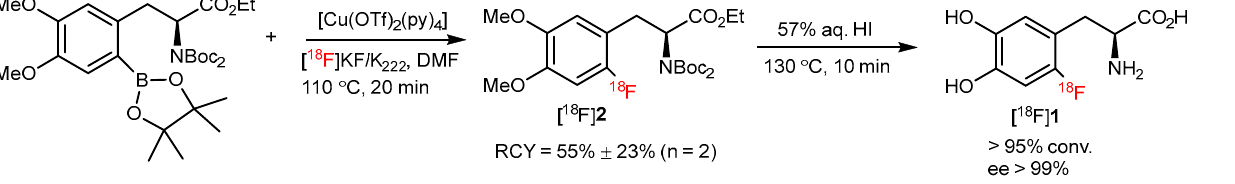
Figure 2. Radiosynthesis of [ 18 F] 1 via Cu-mediated 18 F-fluorination of aryl boronate ester precursor. Modified from Tredwell et al. [35].